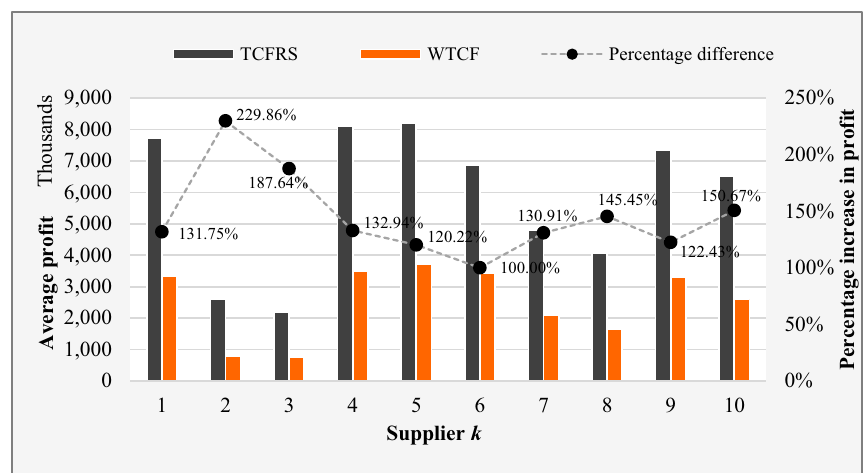
Fig. 5 The effects of the TCFRS contract on the supplier’s profit for test problems in size